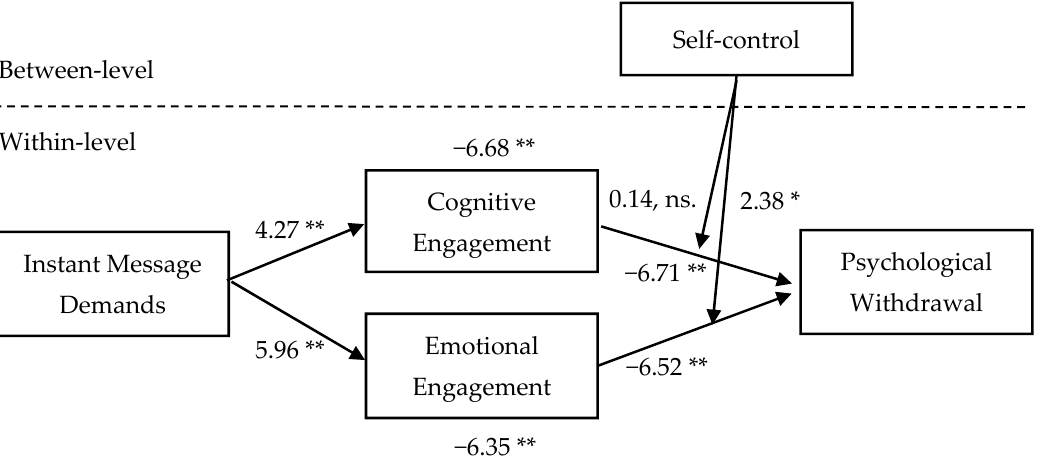
Figure 2. Multilevel path analysis. Note. * p < 0.05. ** p < 0.01. Table 2. Relations between IM demands, emotional engagement, cognitive engagement and psychological withdrawal. Variable